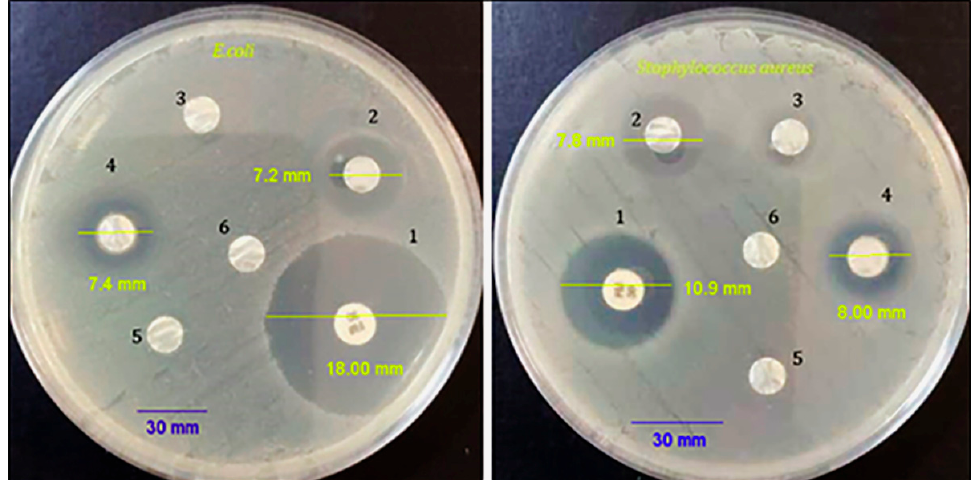
Figure 5. Antimicrobial activity of PCL/CS/NS nanofibers against S. aureus and E. coli . Inhibition zones (mm): 1 — antibiotic; 2 — CS/NS; 3 — PCL/CS; 4 — PCL/CS/NS nanofibers; 5 — PCL; 6 — negative control (D.W.).